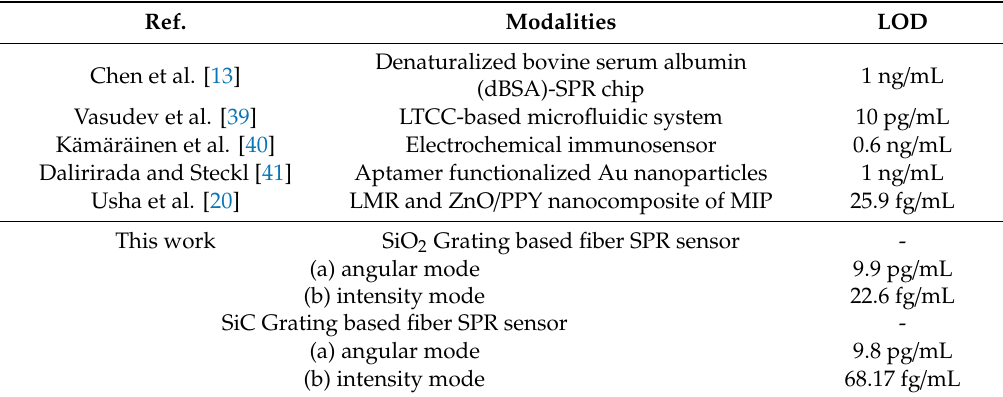
Table 4. LOD comparison with prominent cortisol sensors.